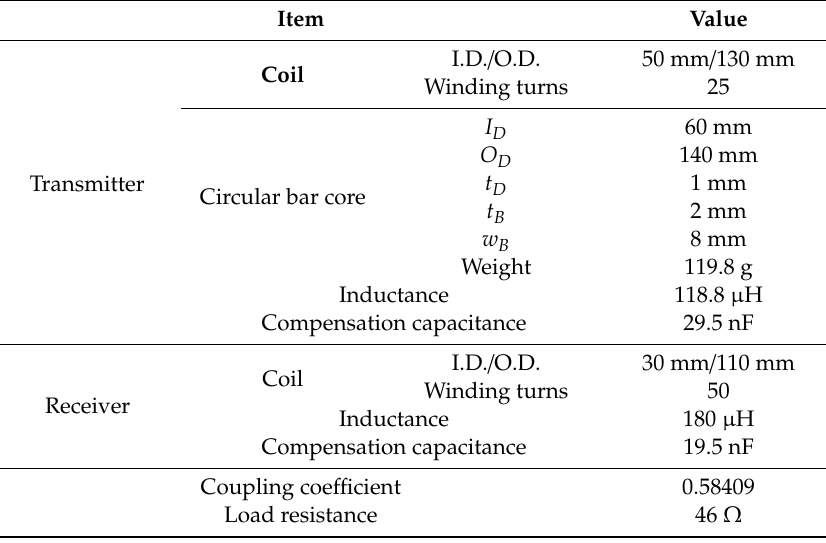
Table 7. Design results of the magnetic coupler and compensation